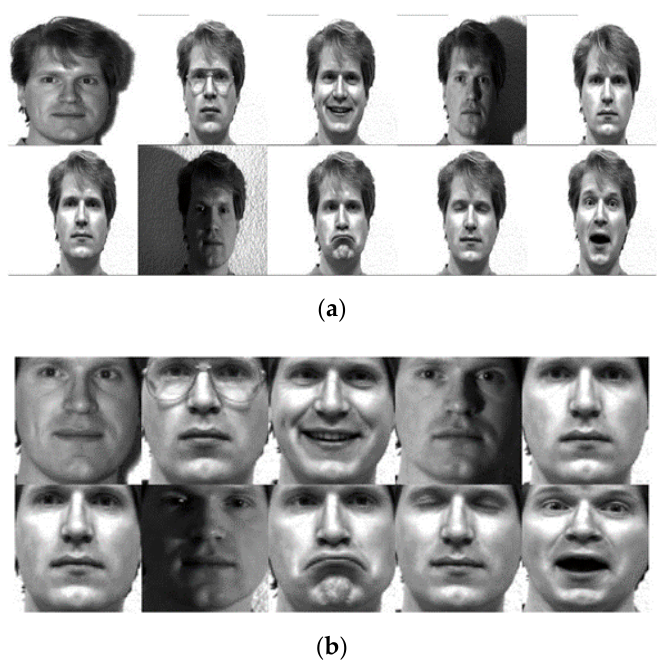
Figure 4. ( a ) A subset of the original Yale database. ( b ) A subset of cropped images [53].